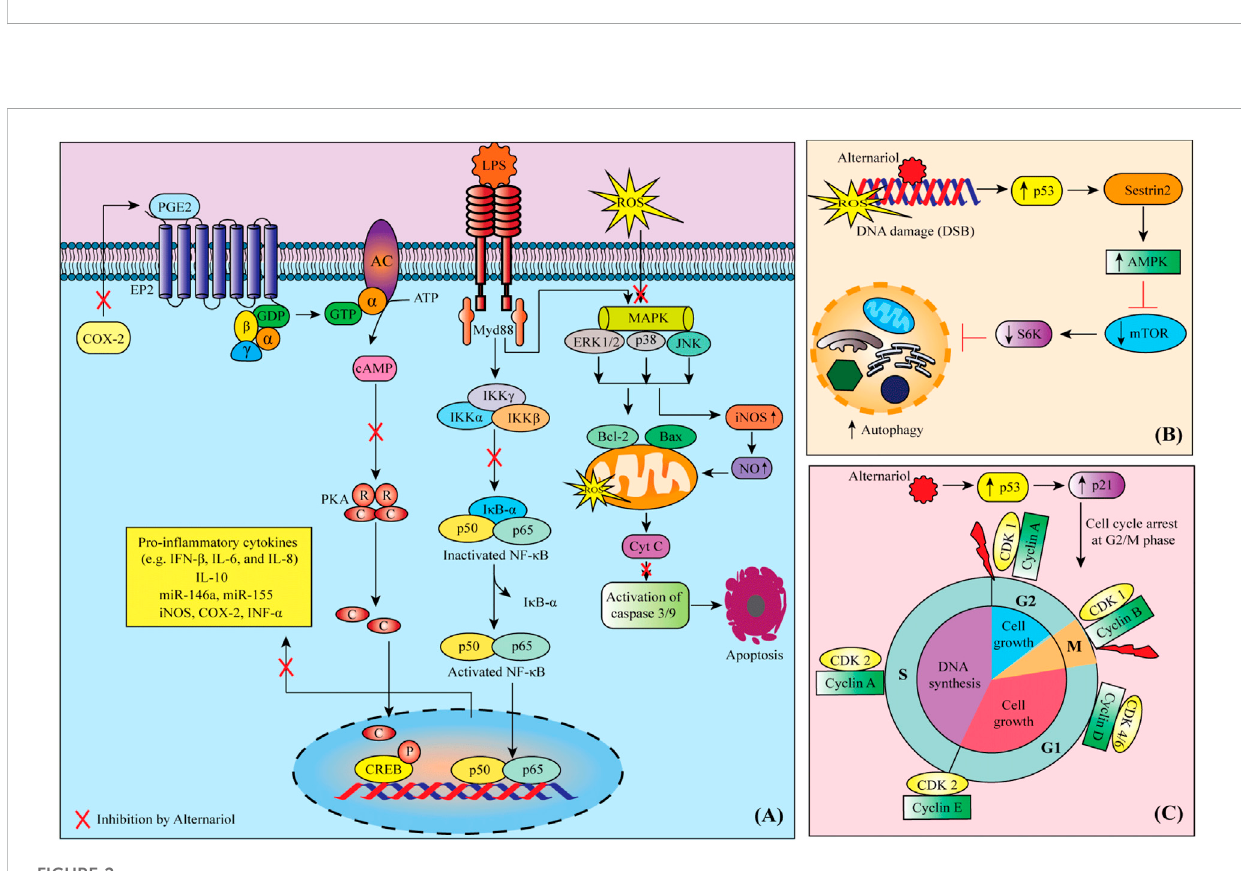
FIGURE 2 Possible mechanisms of anti-cancer activity of alternariol: (A) Alternariol induces apoptosis through targeting multiple deregulated signaling pathways in cancer cells, (B) Possible autophagy mechanism of alternariol through the activation of Sestrin2-AMPK-mTOR-S6K signaling pathway, (C) alternariol moderates the activity of cyclins and cyclin-dependent kinases to induce cell cycle arrest at G2/M phase. Abbreviations and symbols: ↑ increased, ↓ decreased, CDK cyclin-dependent kinase, COX-2 cyclooxygenase-2, CREB cAMP response element-binding, IFN interferon, IL interleukin, iNOS inducible nitric oxide synthase, LPS lipopolysaccharide, MAPK mitogen-activated protein kinase, mTOR mammalian target of rapamycin, PGE2 prostaglandin E2, PKA protein kinase A, ROS reactive oxygen